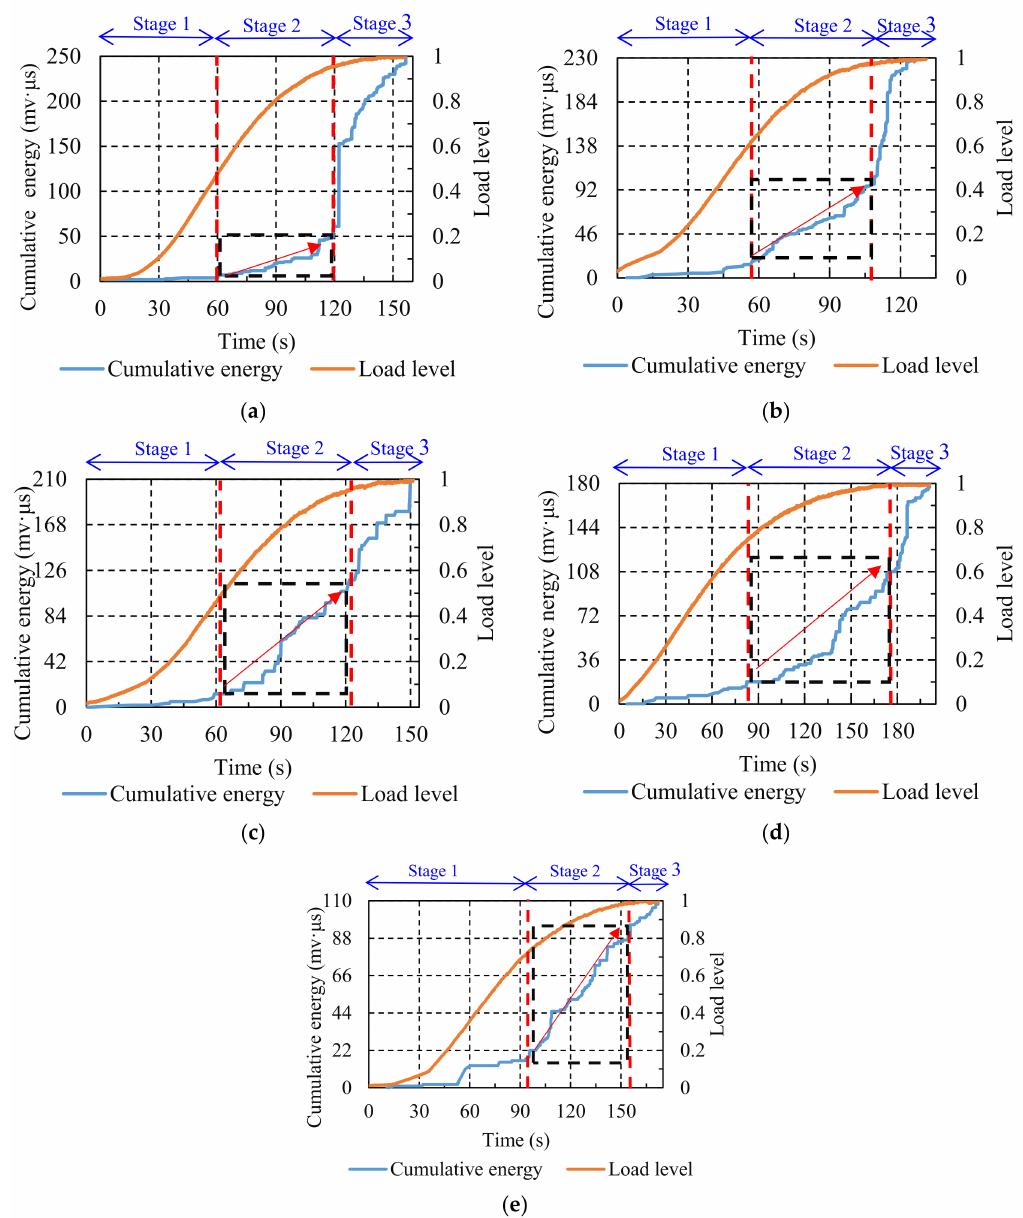
Figure 6. Cumulative energy distribution of specimens treated with various numbers of F–T cycles: ( a ) 0; ( b ) 1; ( c ) 3; ( d ) 5; ( e ) 7. (Red arrow: rising speed of the